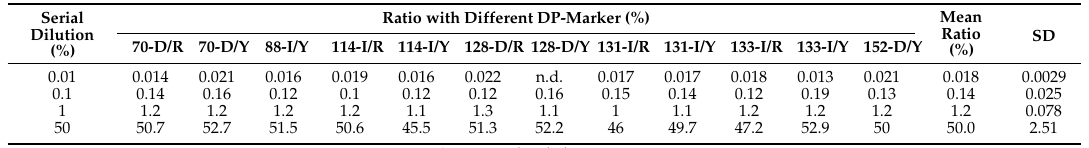
Ratio with Different DP-Marker (%) Mean